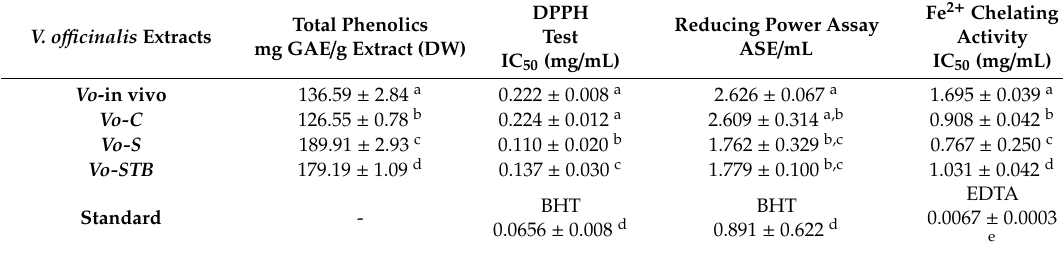
Table 3. Determination of total phenolic content (calculated as gallic acid), free radical scavenging activity (DPPH test), reducing power, and ferrous ions (Fe 2 + ) chelating activity of V. o ffi cinalis extracts.